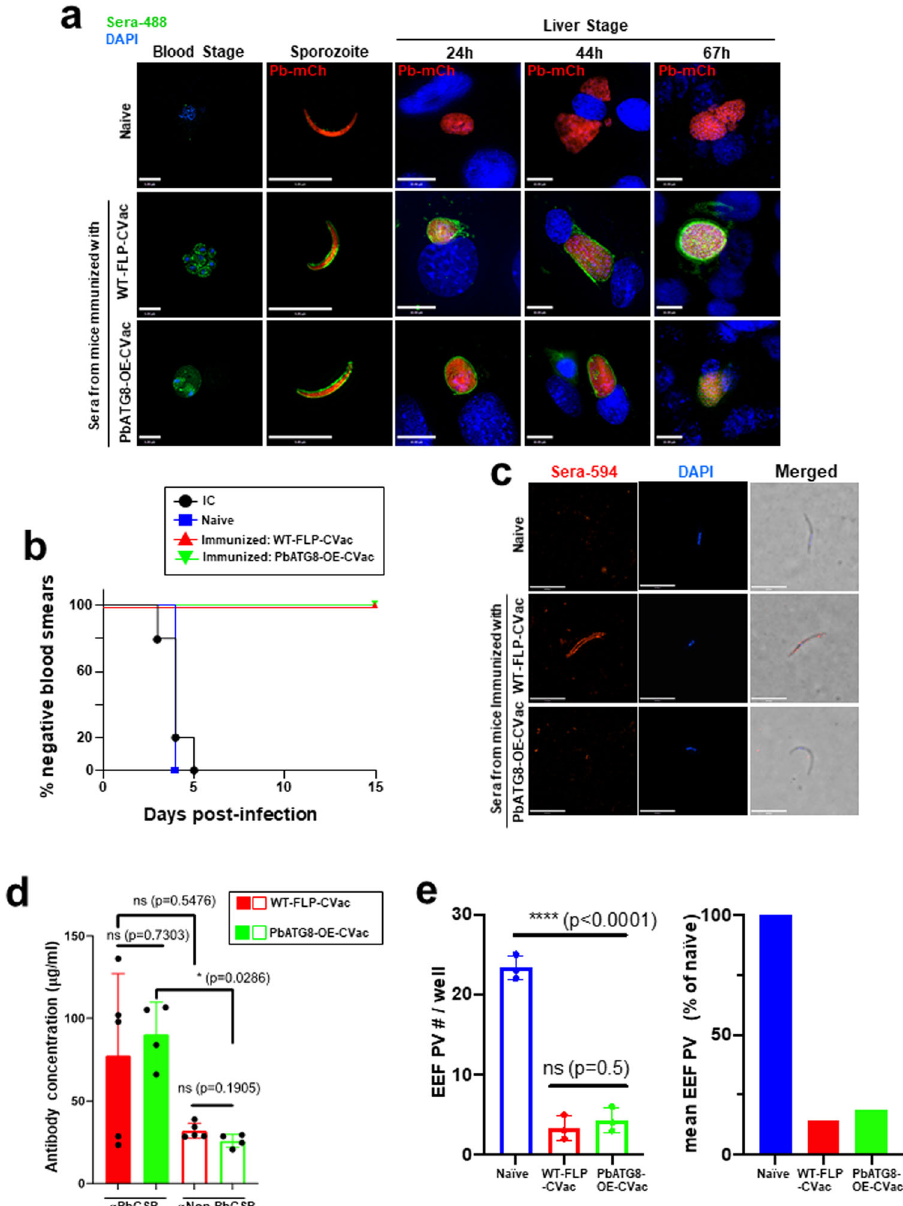
Fig. 8 Antibody response generated by PbATG8-OE-CVac is protective. a IFA using diluted sera from naïve, WT-FLP-CVac or PbATG8-OE- CVac mice performed on mixed blood forms, P. berghei expressing mCherry (Pb-mCh) sporozoites or liver forms at different time points. Mice were immunized as described in Fig. 3b and sera used for IFA were collected 4 weeks after the last immunization. Fluorescence signal was detected by Alexa-488-conjugated secondary anti-mouse-IgG. Nucleus was stained with DAPI. Scale bars, 10 μ m. b SNA to monitor infection in vivo. 2 × 10 4 WT-Pb-ANKA sporozoites were incubated on ice for 45 min with 1:6 diluted sera from naïve or immunized mice, and the sporozoite – antibody mixture was injected intradermally to naïve Swiss-Webster mice and parasitemia was monitored for 15 days. c IFA using diluted sera from naïve or immunized mice on non-permeabilized air-dried PfCSP-expressing P. berghei sporozoites. Alexa-594-conjugated secondary anti-mouse IgG were used to detect antibody signal at the sporozoite surface. Scale bars, 5 μ m. d Determination of anti-sporozoite antibody concentration. Anti-PbCSP and anti-Non-PbCSP antibody concentration in each immunized mouse was determined using standard curve method, using 5000 WT-Pb-ANKA sporozoites or P. berghei sporozoites expressing PfCSP per well, respectively, for ELISA. Mean data ± SD are representative of experiment done twice for both anti-PbCSP and anti-Non-PbCSP antibody concentration determination ( n = 5/group for WT-FLP-CVac and n = 4 for PbATG8-OE-CVac). Statistical signi fi cance was determined by Mann – Whitney test. e SNA to monitor infection in vitro. Number of EEF PV were calculated 48 h after addition of serum exposed m-Cherry-expressing P. berghei sporozoites to cultured Hepa1-6 cells. Data are means ± SD of experiment done in triplicate. Left panel shows absolute number of EEF/well and right panel averaged EEF number normalized to naïve serum-exposed sporozoites. Statistical signi fi cance was determined by Mann – Whitney forms, though the majority of their target antigens, as well as the antibodies (e.g., by decreasing sporozoite motility and invasion) is protective capacity of these antibodies, are unknown. P. berghei - greater at the inoculation site than in the bloodstream 57 . mCherry sporozoites are coated by protective antibodies from Antibodies generated by mice immunized with PbAGT8-OE- mice immunized with either PbAGT8-OE-CVac or WT-FLP. CVac bind to a plethora of antigens expressed by blood and liver